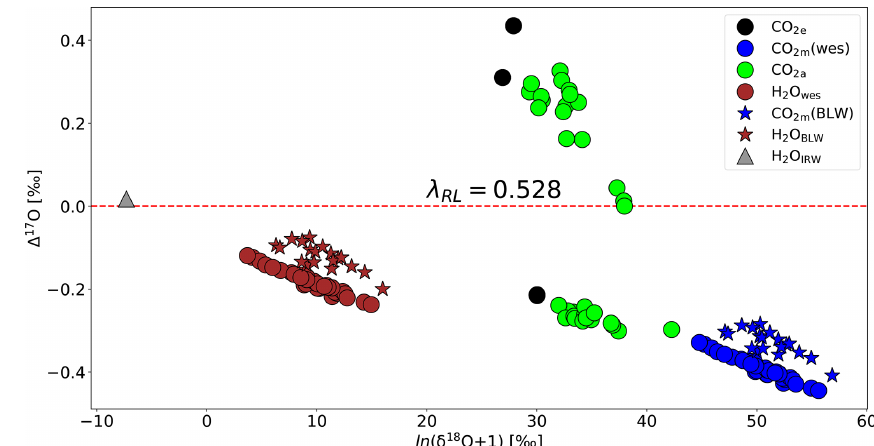
Figure 6. Isotopic composition of various relevant oxygen reservoirs that affect the (cid:49) 17 O of atmospheric CO 2 during photosynthesis: irrigation water (gray triangle), calculated leaf water at the evaporation site (brown circles), measured bulk leaf water (brown star), CO 2 entering the cuvette (black circles), CO 2 leaving the leaf cuvette (green circles), CO 2 equilibrated with leaf water at the evaporation site (blue circles), and CO 2 equilibrated with bulk leaf water (blue stars). (cid:49) 17 O is calculated with λ = 0 .